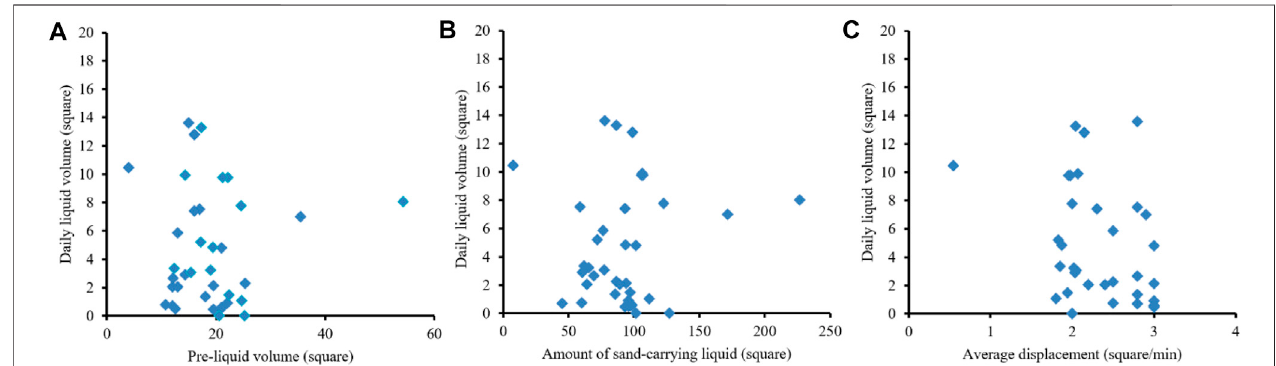
FIGURE6| Effectsofpre- fl uidvolume,sand-carrying fl uidanddisplacementon fl uidproductionduringfracturing. (A) Pre-liquidvolumeanddailyliquidvolume; (B) Amount of sand-carrying liquid and daily liquid volume; (C) Average displacement and daily liquid volume.